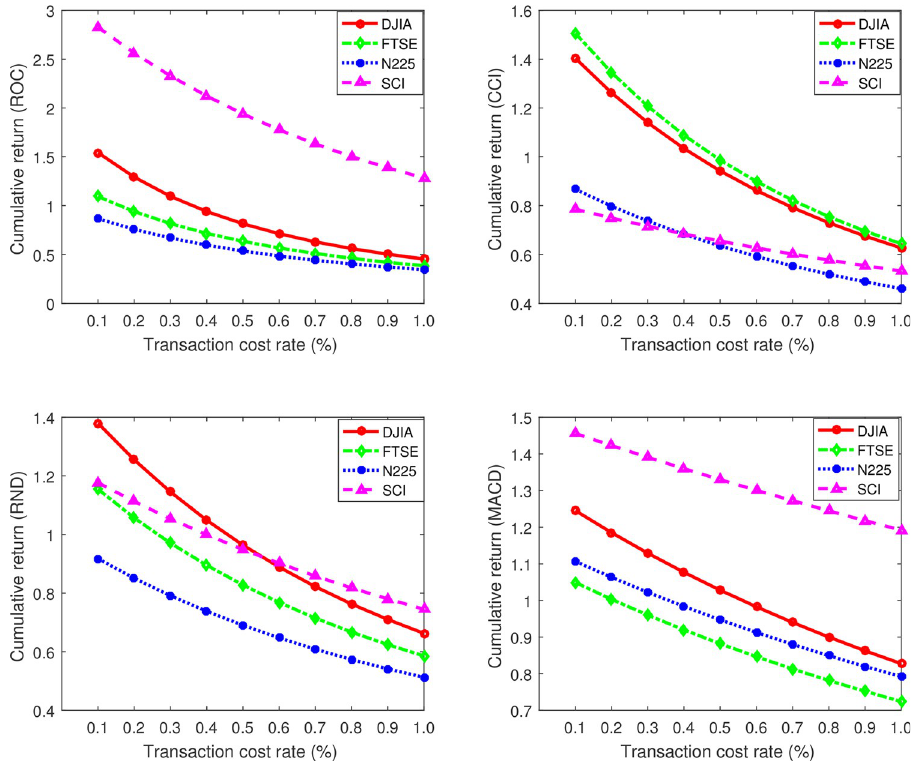
Fig 4. The influence of k on the cumulative return for the stock indices. From top to bottom, from left to right, we show the result of ROC, RND, CCI and MACD strategies, respectively. Further analysis can be seen in text.